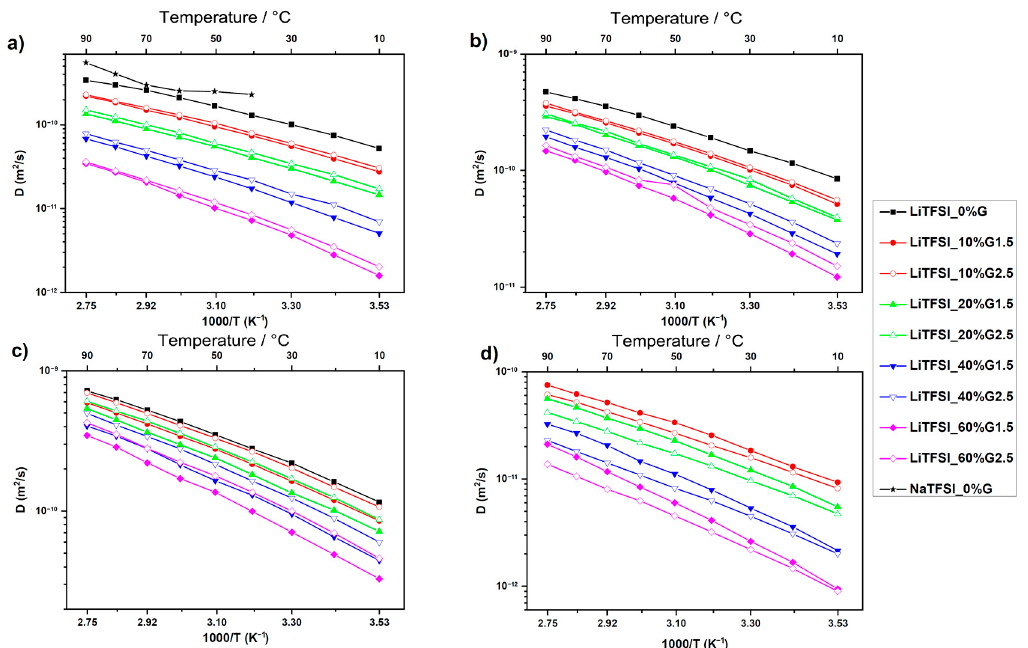
Figure 36. Temperature dependences of the NMR self-diffusion coefficients for the LiTFSI-based electrolytes for Li cation ( a ), TFSI anion ( b ), PC molecules ( c ), and PAMAM molecules ( d ). Solid lines are guides for the eye [136].